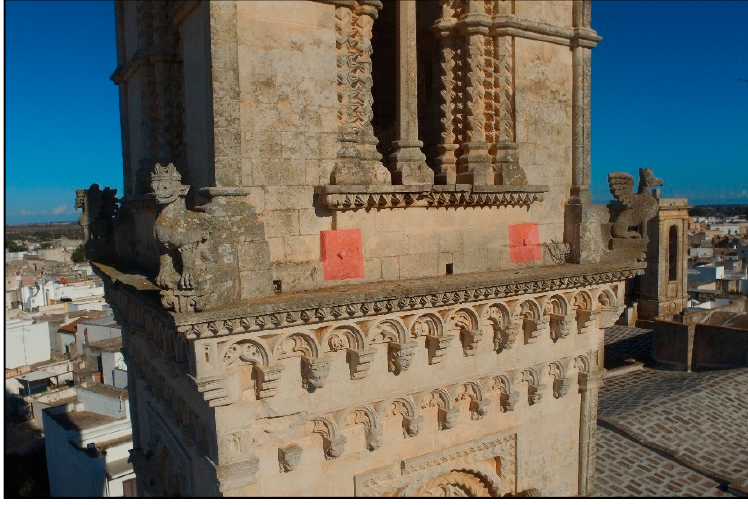
Figure 2. Detail of steel ties.